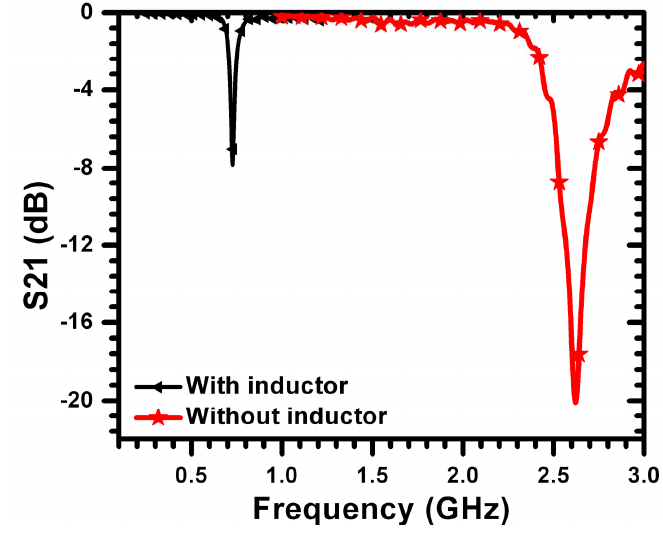
Figure 14. Minimum transmission coefficient of the sensor obtained from measurement with and without inductors of 6 -mm CSRR.